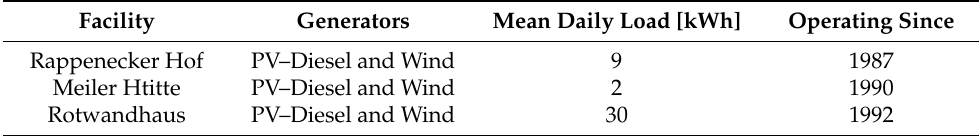
Table 2. PV–wind systems by the Fraunhofer Institute